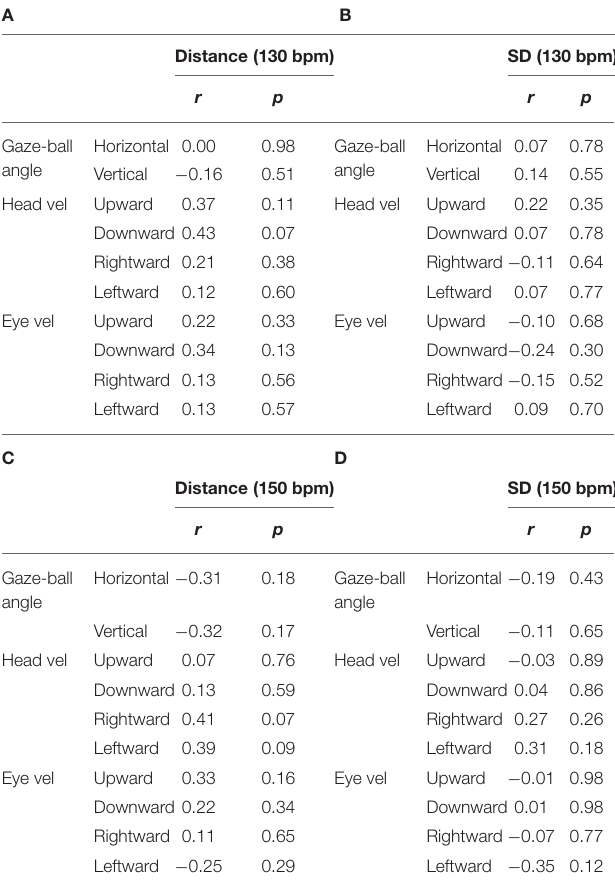
TABLE 2 | Pearson correlation between distance and the gaze-ball angle, eye velocity, and head velocity in each tempo. A